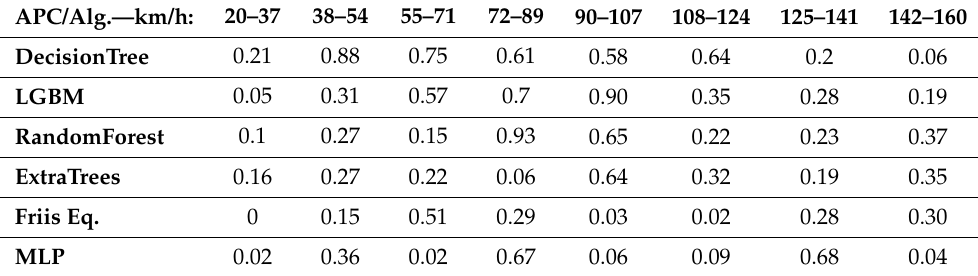
Table 7. The 8-classes—Classifiers ranking. Total APC per class and Friis equation total APC .